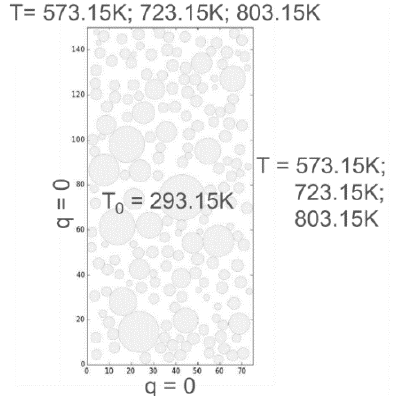
Figure 6. Synthetic specimen with loading and boundary conditions implemented in Abaqus [25].